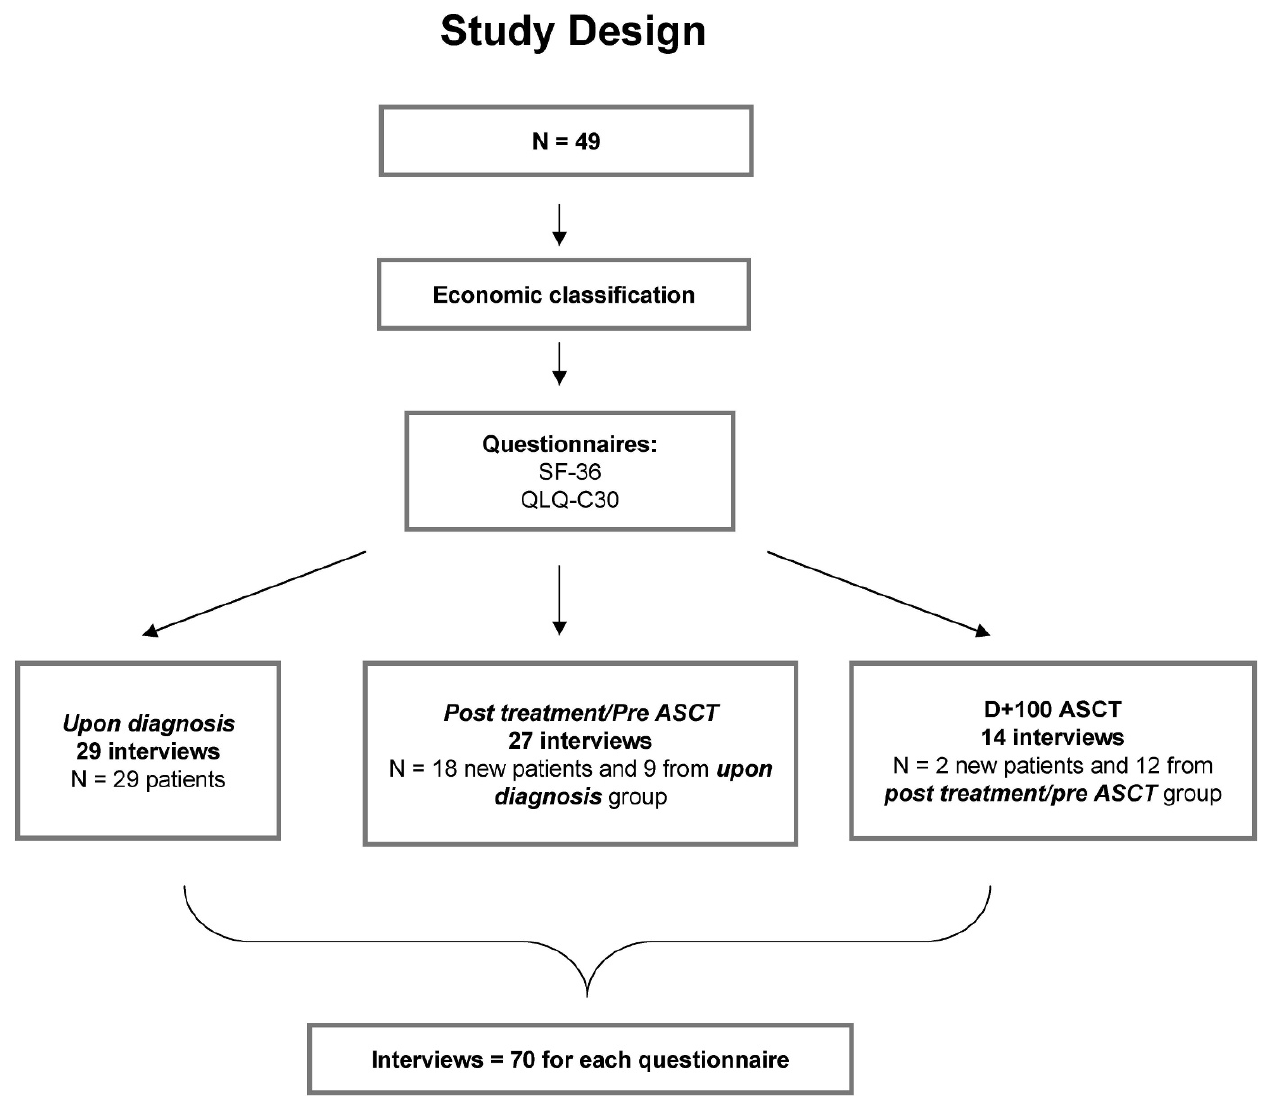
Figure 1 - A flow diagram of the study design. ASCT - autologous stem